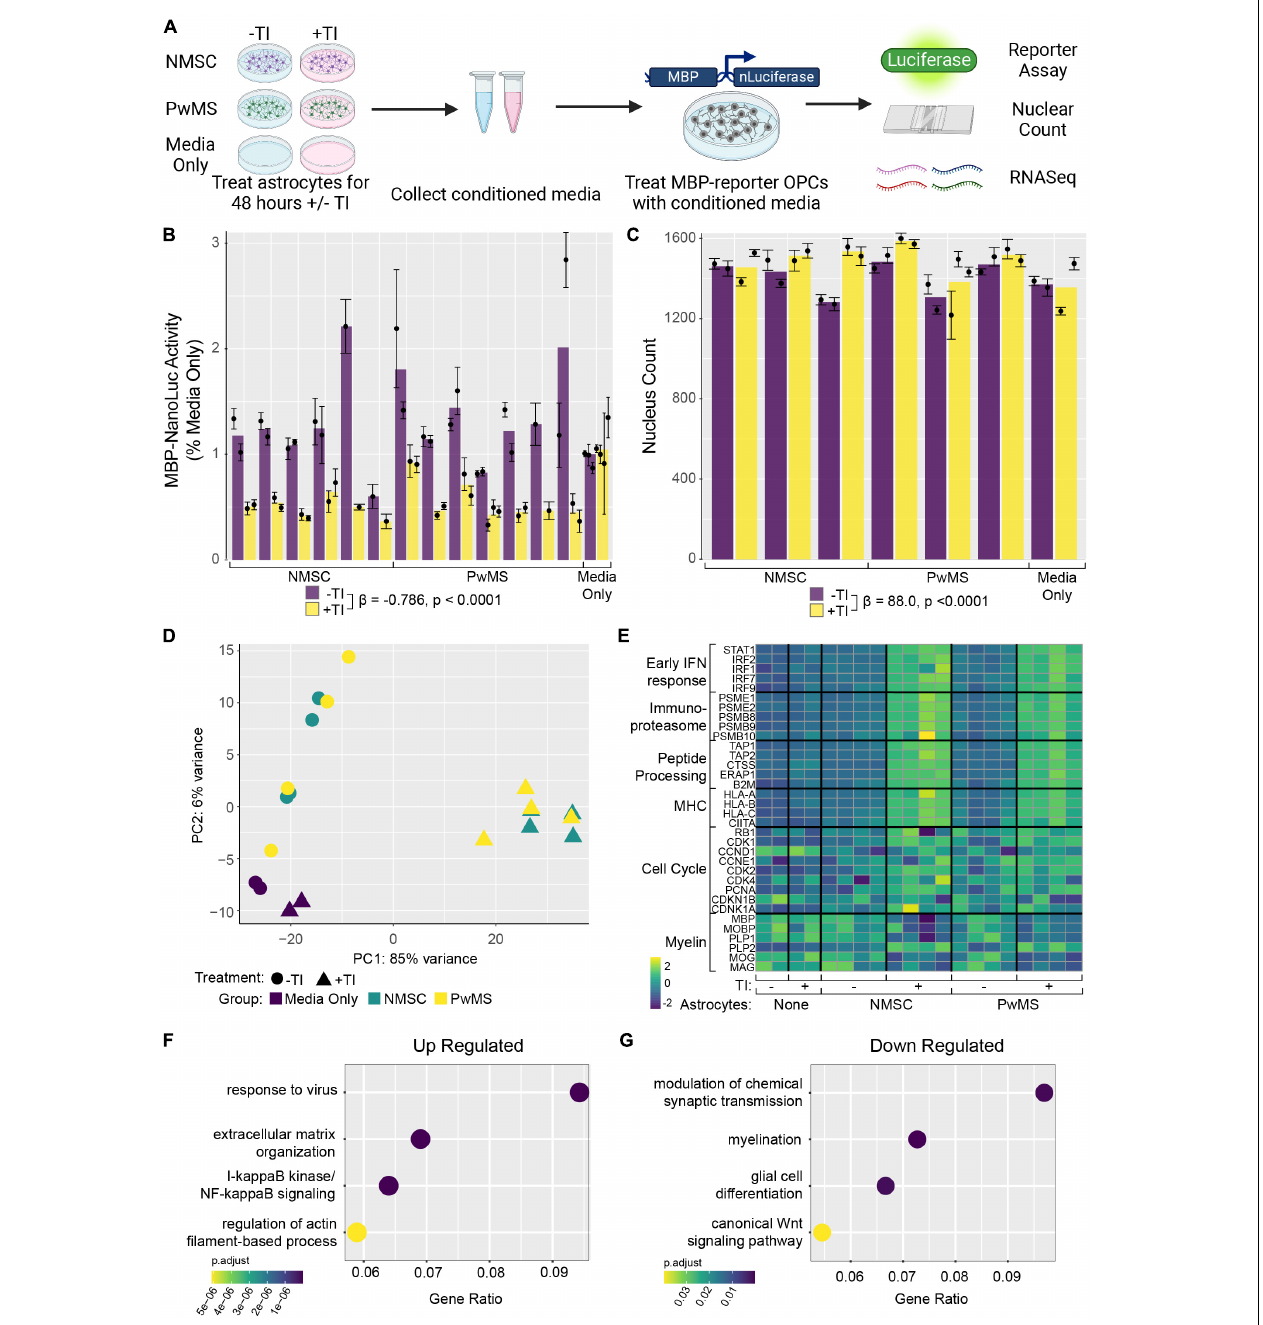
FIGURE 3 | Conditioned media from TI stimulated astrocytes suppresses human OPC differentiation. (A) Schematic depicting experiment. (B) Barplot showing Nanoluciferase activity (normalized to media only control) on Y -axis. Each dot represents a well of hiPSC derived astrocytes whose media was placed onto five identical replicate wells of hOPC reporter cells. Columns represent mean of replicate astrocyte samples, dots represent mean of replicate OPC wells, and error bars represent standard error of the mean of replicate OPC wells. (C) Barplot showing nuclear counts following treatment with astrocyte CM, data presented in same format as in (C) . (D) Principle component analysis of hOPC reporter RNA libraries comparing samples treated with media only, media only with TI, and CM from NMSC and PwMS derived astrocytes treated with or without TI. (E) Heatmap showing relative expression of genes previously associated with inflammatory OPCs in hOPC reporter cells treated with astrocyte CM (and media only controls). Dotplots showing selected GO terms found to be enriched in up-regulated (F) and down-regulated (G) genes from hOPC reporter cultures treated with astrocyte CM stimulated with or without TI. Genes were identified as differentially expressed if they had adjusted p -value less than 0.05 and Log 2 Fold Changes values greater than 0.5 or less than –0.5, respectively. Statistical analyses reported in (B,C) are result of linear mixed effect models.